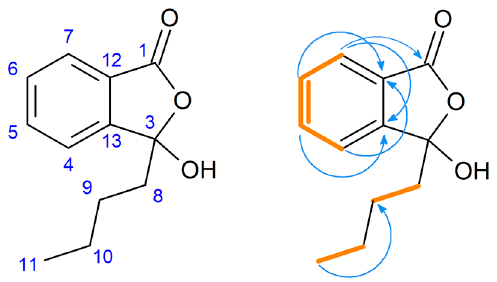
Figure 5. Pivotal Correlation Spectroscopy (orange bolded) and Nuclear Multiple Bond Coherence (arrows) correlations of 3-butyl-3-hydroxyphthalide ( 2 ).